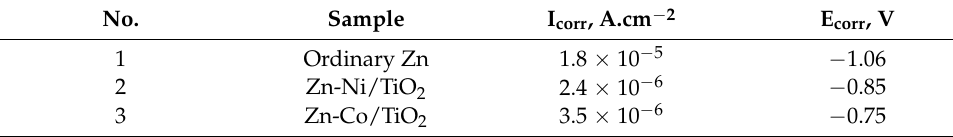
Figure 12. Polarization resistance measurements of ordinary Zn, System A and System B. The most important electrochemical parameters are presented in Table 2. Table 2. Some electrochemical parameters from PDP